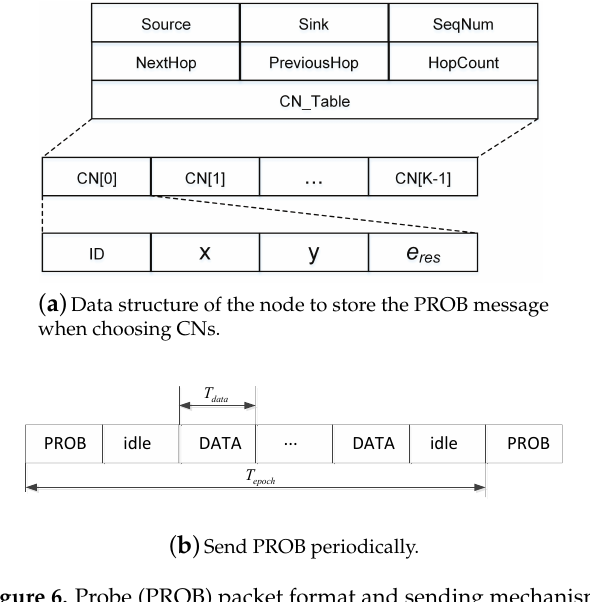
Figure 6. Probe (PROB) packet format and sending